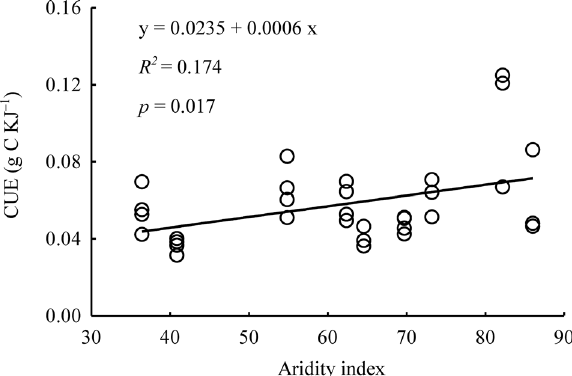
Fig 6. The linear relationship between use efficiency of caloric value (CUE) and aridity